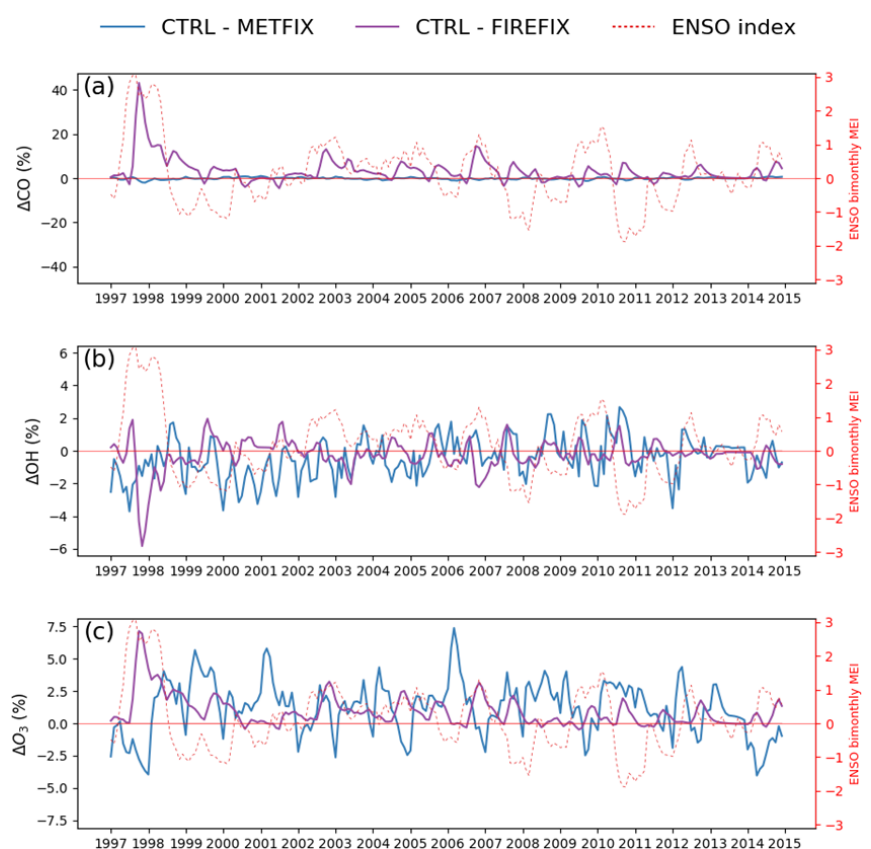
Figure 4. Time series of simulated differences (%) between the control and the fixed meteorology (CTRL – METFIX, blue line) and fixed fire emissions (CTRL – FIREFIX, purple line) simulations for the global tropospheric burden of (a) CO, (b) OH and (c) O 3 . The ENSO bimonthly mean multivariate index is plotted with the dashed red line using the right-hand y axis in each